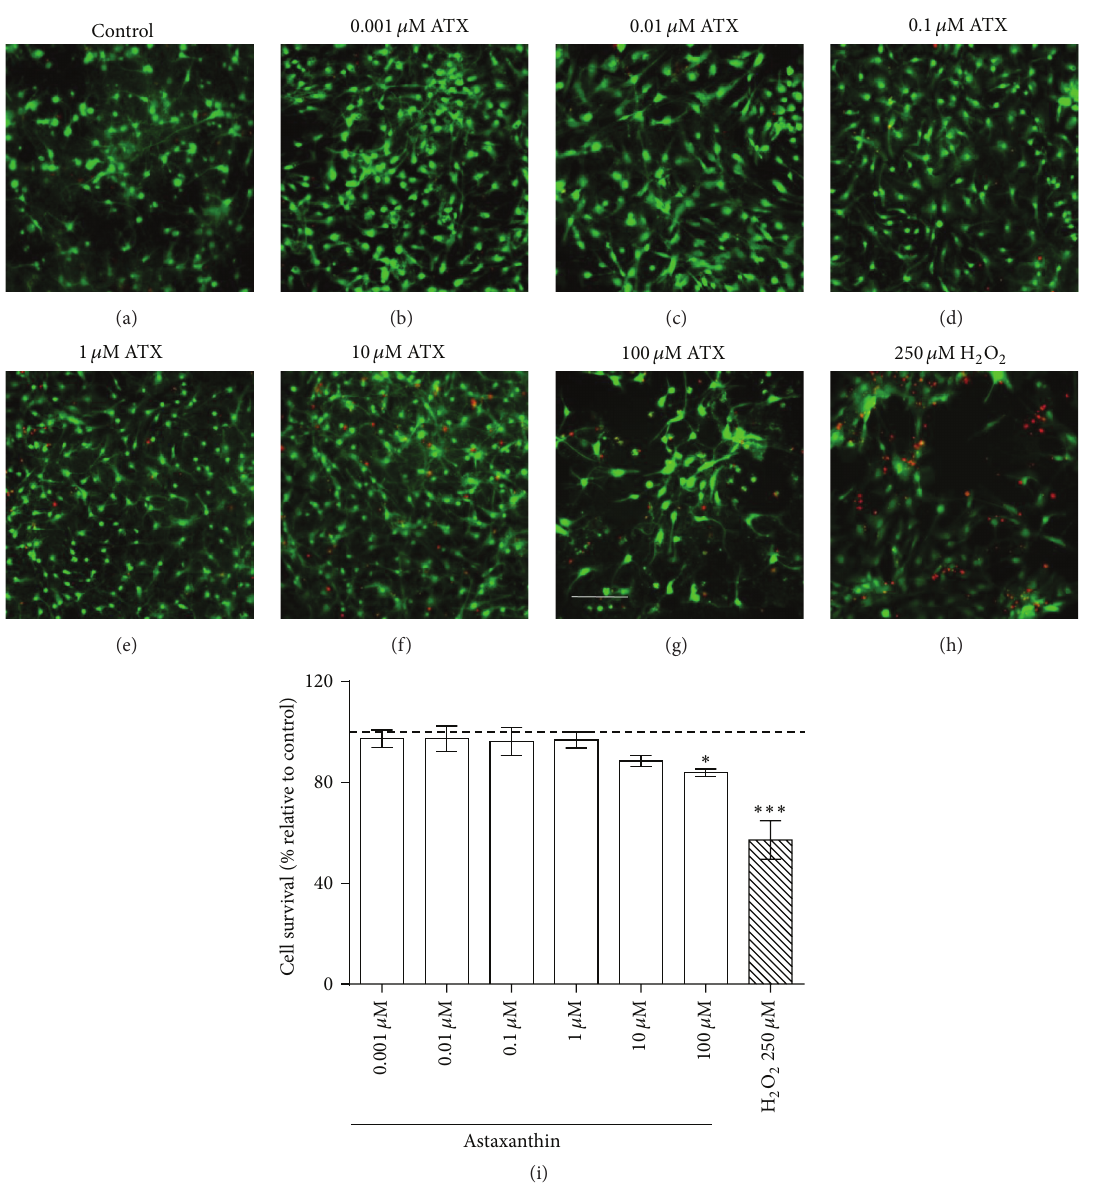
Figure 1: Lack of toxicity of ATX ( ≤ 10 𝜇 M) to primary hippocampal cultures. Representative live/dead fluorescence images ((a)–(h)) of neuronal hippocampal cultures (13–15DIV) incubated for 24 h in the presence of vehicle (a) or treated with 0.001 𝜇 M (b), 0.01 𝜇 M (c), 0.1 𝜇 M (d), 1 𝜇 M (e), 10 𝜇 M (f), and 100 𝜇 M (g) ATX. In (h), 250 𝜇 M H 2 O 2 was used to induce cell death. Live and dead neurons were identified by green calcein and red DNA-bound ethidium fluorescence, respectively. Scale bar: 50 𝜇 m. (i) shows quantitative analysis of cell survival incubated with different concentrations of ATX (white bars) and under H 2 O 2 stimulation (hatched bar). Results are expressed as percentages relative to the viability of the control, untreated cultures. Values correspond to mean ± SE of six independent experiments ( 𝑛 = 6 , corresponding to cultures from 6 different animals; in all experiments, each condition was tested at least in triplicate), with different neuronal cultures. Control cultures exhibited 85% of cell viability on average. Statistically significant differences among experimental conditions were evaluated by one-way ANOVA followed by Bonferroni’s multiple comparison test ( ∗ 𝑝 < 0.05 and ∗∗∗ 𝑝 < 0.0001 compared to